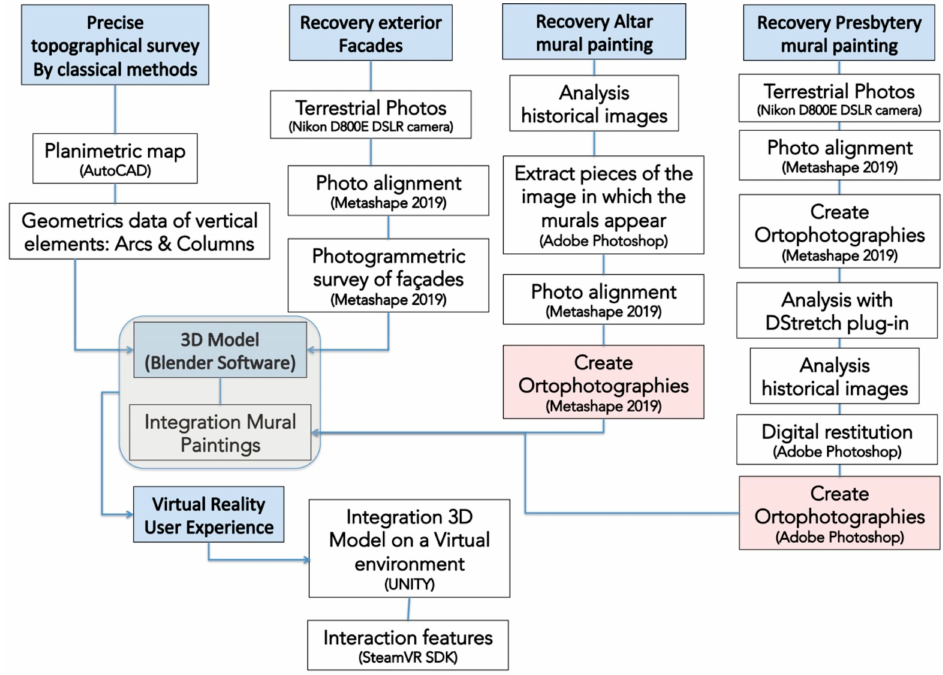
Figure 2. Workflow combining topographical survey, terrestrial photogrammetry and analysis, and the processing of digital images for rendering building reconstructions in